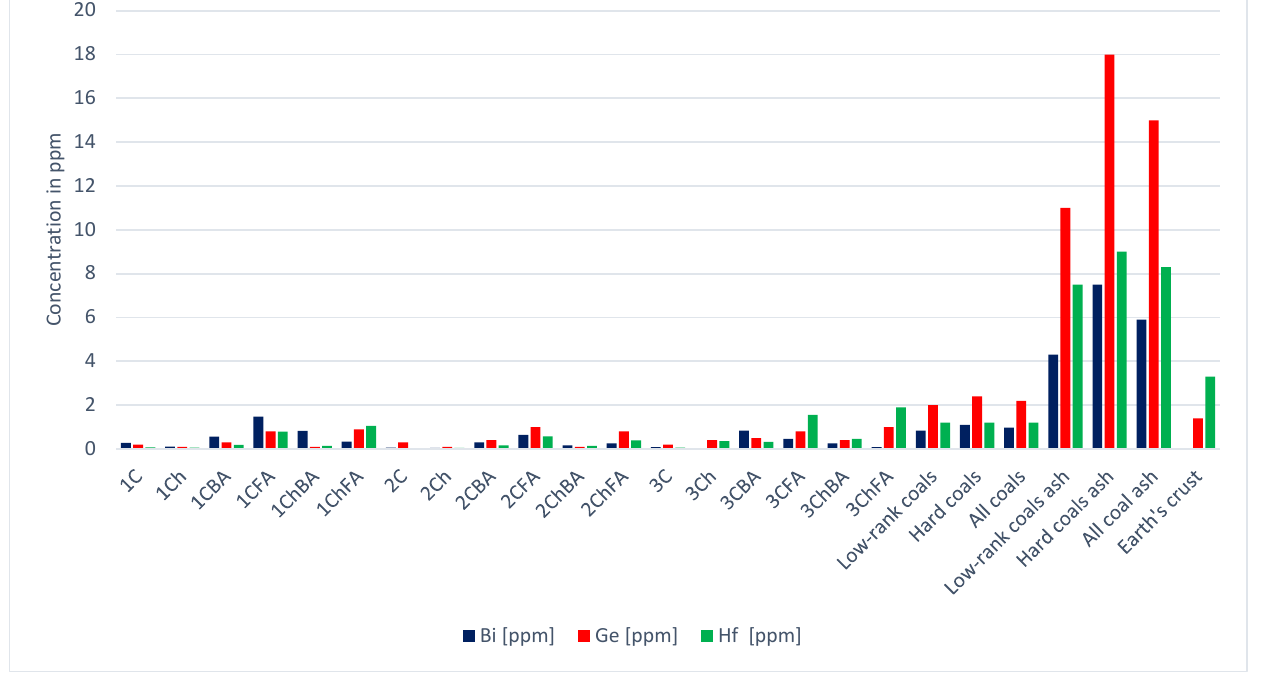
Figure 3. The Bi, Ge, and In content of coal, char, ashes and their Clarke values [21].